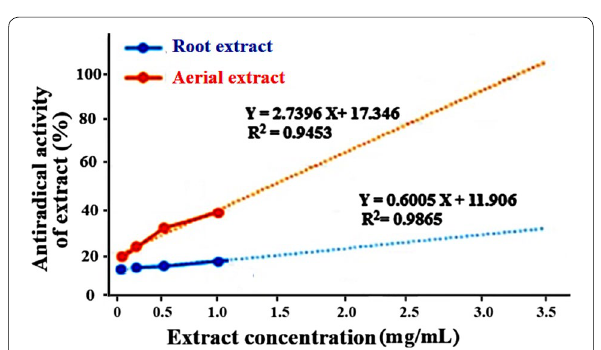
Fig. 6 Linear relationship between inhibition percentage of the extract and extract